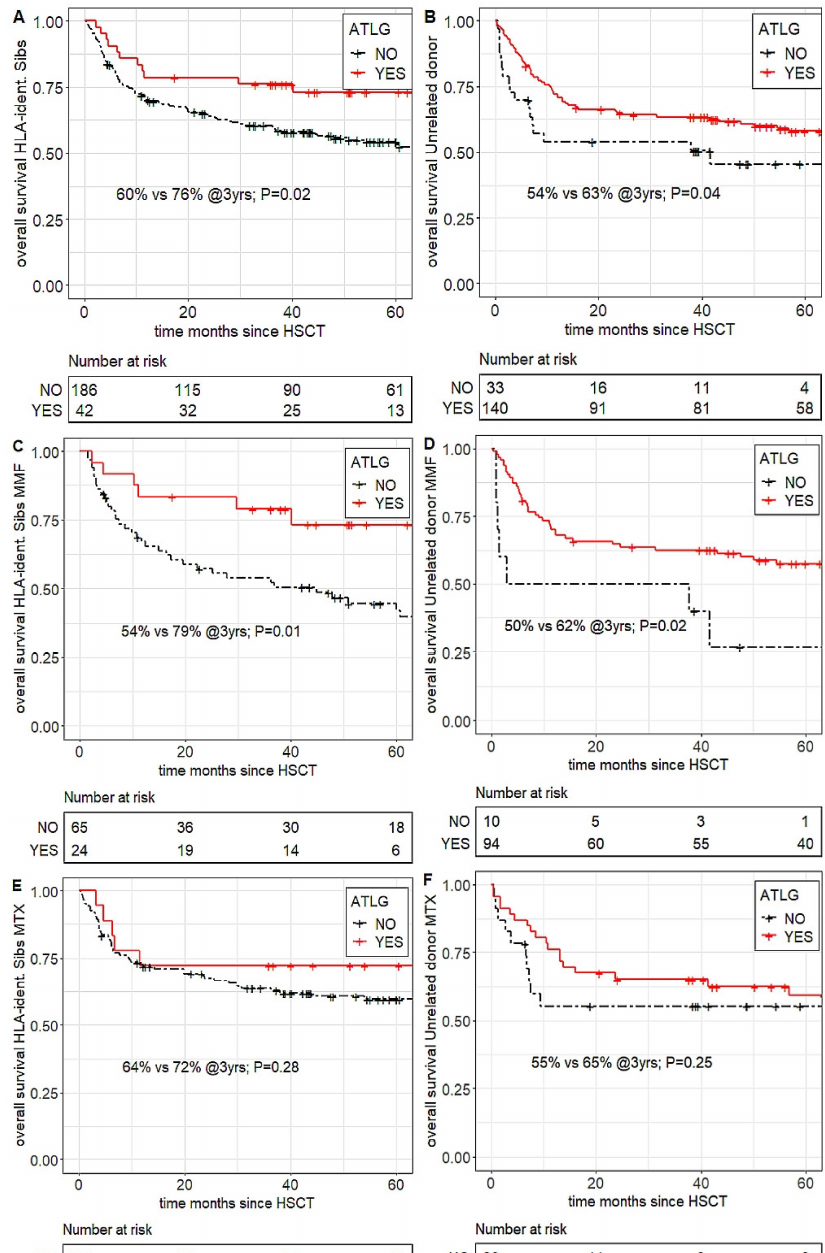
Figure 2. OS by ATLG treatment and donor relation. Red line, ATLG; black line, no ATLG. ( A ) all matched-related HSCT; ( B ) all unrelated HSCT; ( C ) MMF-based matched-related HSCT; ( D ) MMF-based unrelated HSCT; ( E ) MTX-based matched-related HSCT; ( F ) MTX-based unre- lated